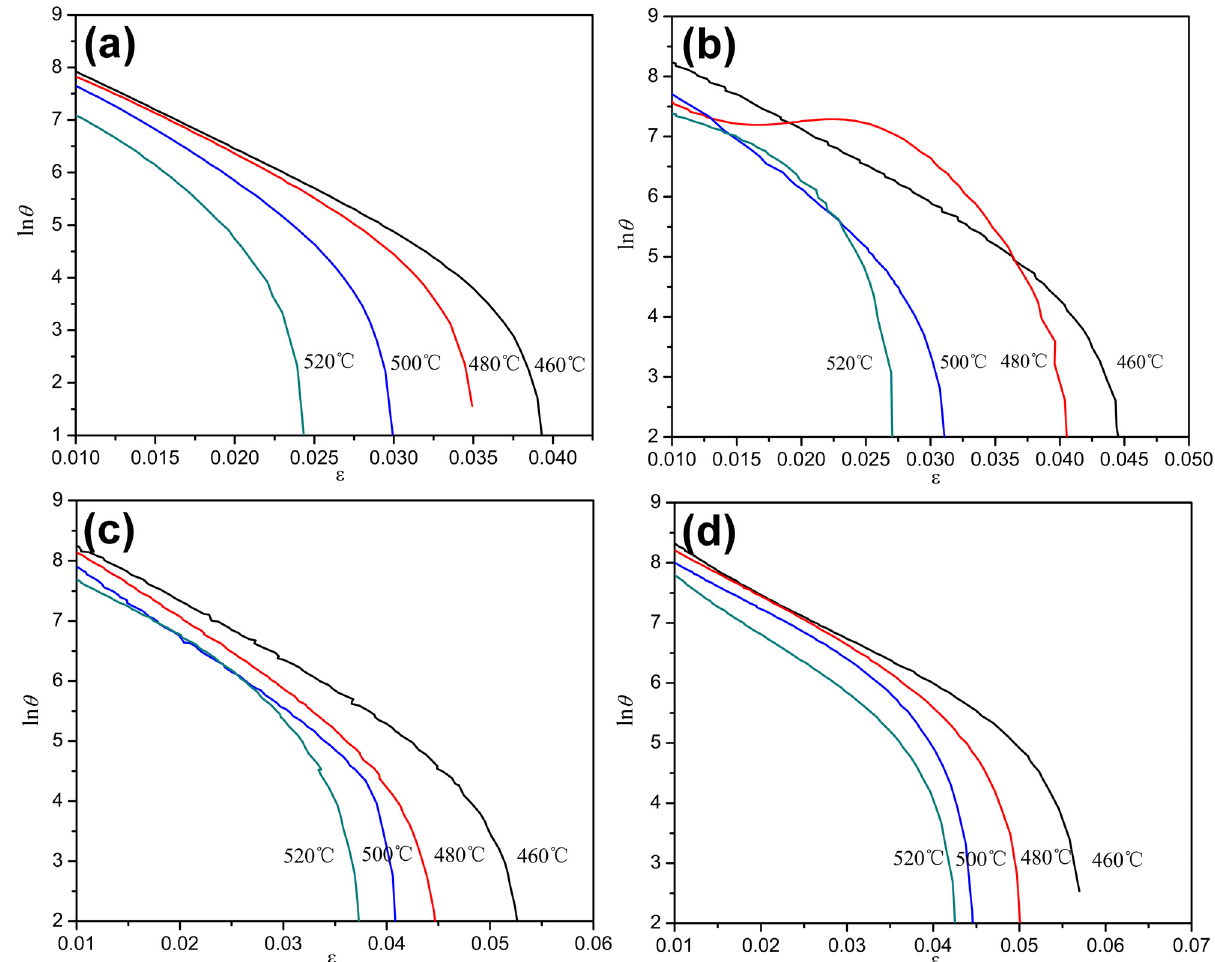
Figure 8: The relationship curves between θ ln and ε under di ff erent deformation conditions; ( a ) ε ̇ = 0.01 s − 1 ; ( b ) ε ̇ = 0.1 s − 1 ; ( c ) ε ̇ = 1 s − 1 ; and ( d ) ε ̇ = 5 s − 1